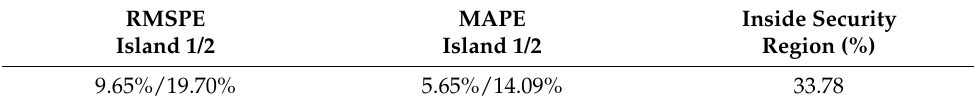
Table 5. Performance on testing data based on traditional RAS calculations.